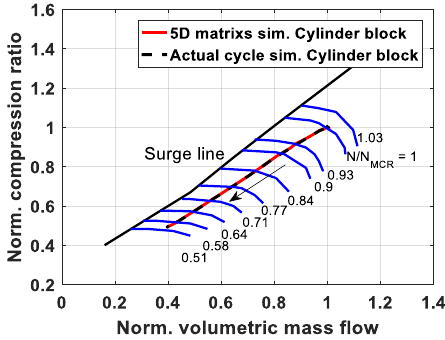
Figure 21. TC deceleration in the compressor map.